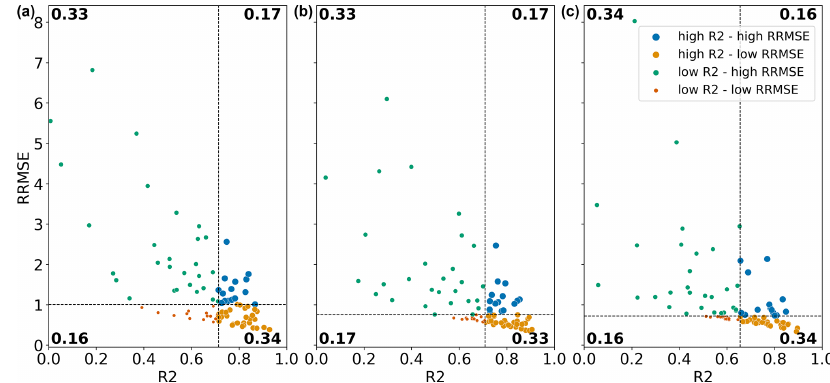
Figure 9. Plot of R 2 and RRMSE values per water province, categorized in four quartiles based on their median R 2 and RRMSE values, respectively, for 1k_1k, 10k_10k, and 50k_50k runs (from left to right). Values in the corners of the quartiles represent the fraction of data points in the respective quartiles. Table 4. Overview of indicators for computational demand of the runs at different model resolutions. The file sizes refer to output for one variable. 1K 10K 50K Run time – Without parallelization 3600h 36h 9h – With parallelization 204h Not parallelized File size monthly data 25000MB 500MB 15MB File size daily data 750000MB